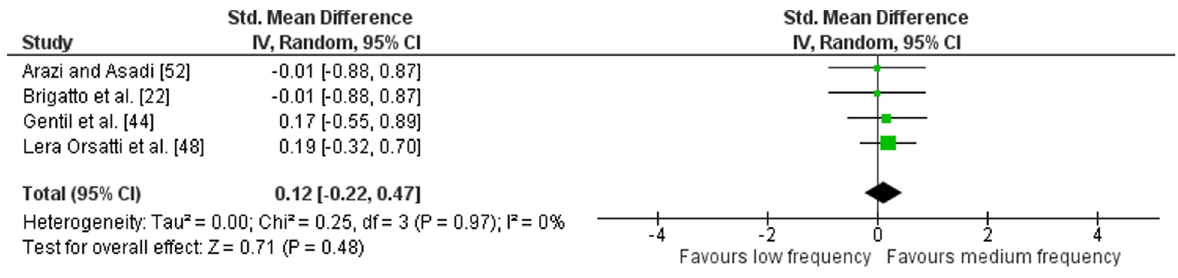
Fig. 11 Low vs. medium weekly training frequency. Pre- vs. post-mean ES strength difference on upper body exercise. The vertical line indicates the overall estimate of combined multi-joint and isolation studies pre- vs. post-mean ES strength difference. Horizontal lines indicate 95% CI, squares estimates, whereas square size is proportional to sample size, and rhombs ’ meta-analytically pooled